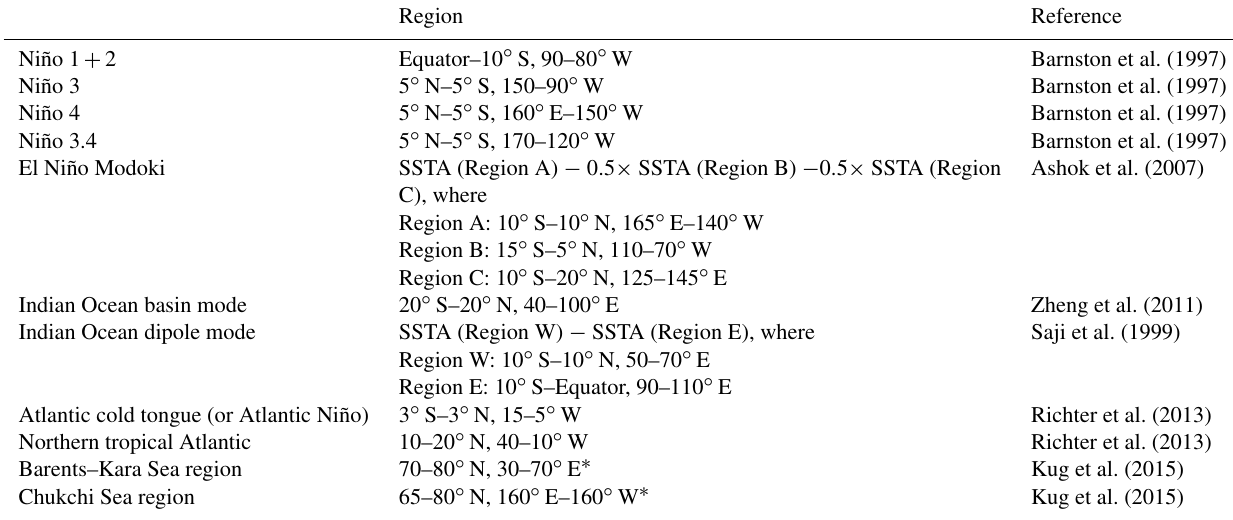
Table 2. Tropical and Arctic SST indices considered in this study. Indices are calculated as area-weighted averages of SST anomalies (SSTAs) relative to the 1981–2010 base period in each specified